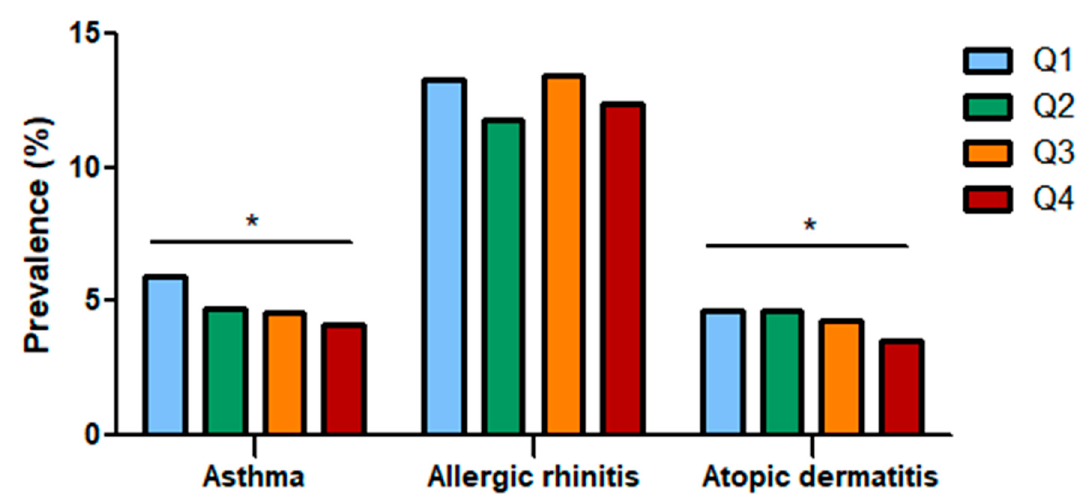
Figure 2. Prevalence of asthma, allergic rhinitis, and atopic dermatitis according to total fiber intake quartiles. The prevalence of asthma and atopic dermatitis decreased as dietary fiber intake increased. Q: Quartile. *: Statistically significant. Table 2. Logistic regression analysis of the association between fiber intake and the prevalence of allergic diseases. Logistic regression analysis revealed that the prevalence of asthma decreased in